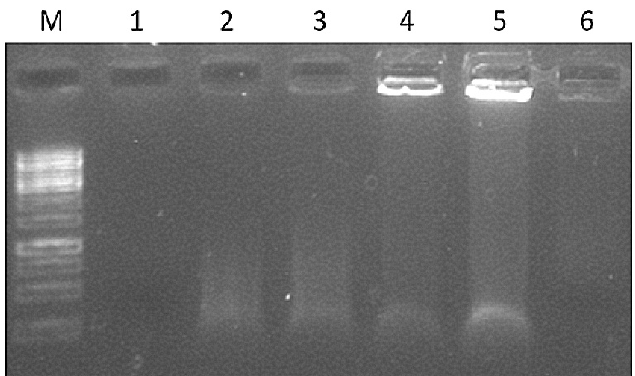
Figure 4. Agarose gel analysis of PVY–Fel d 1 vaccine variants at a concentration of 1.5 mg/mL. M—